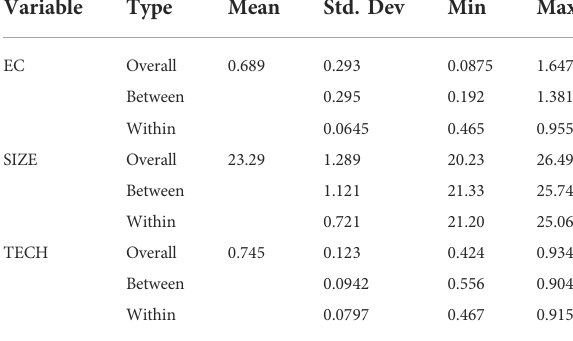
TABLE 1 Descriptive statistics of